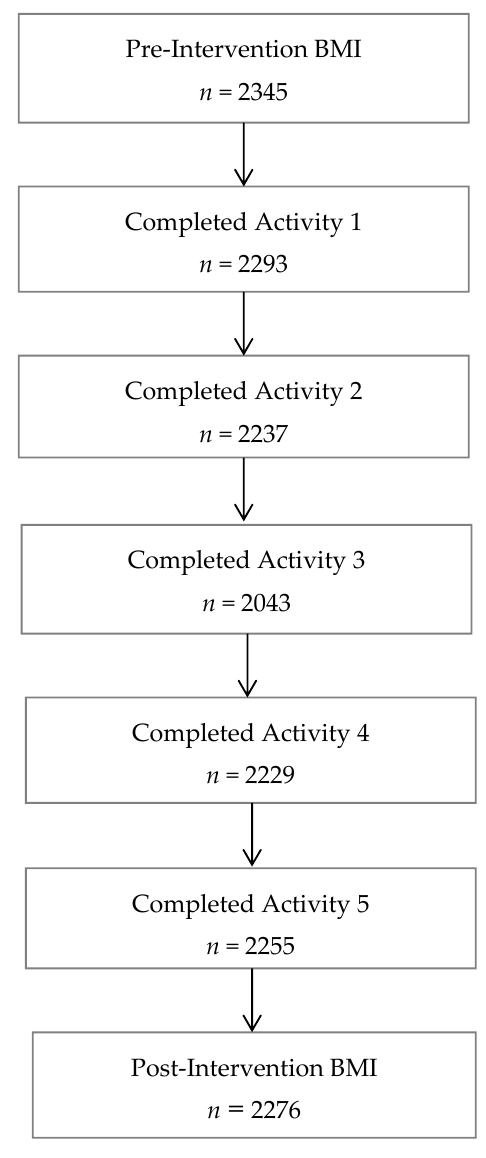
Figure 2. Flowchart of student participation in the ORANGE Phase ‐ II school intervention.